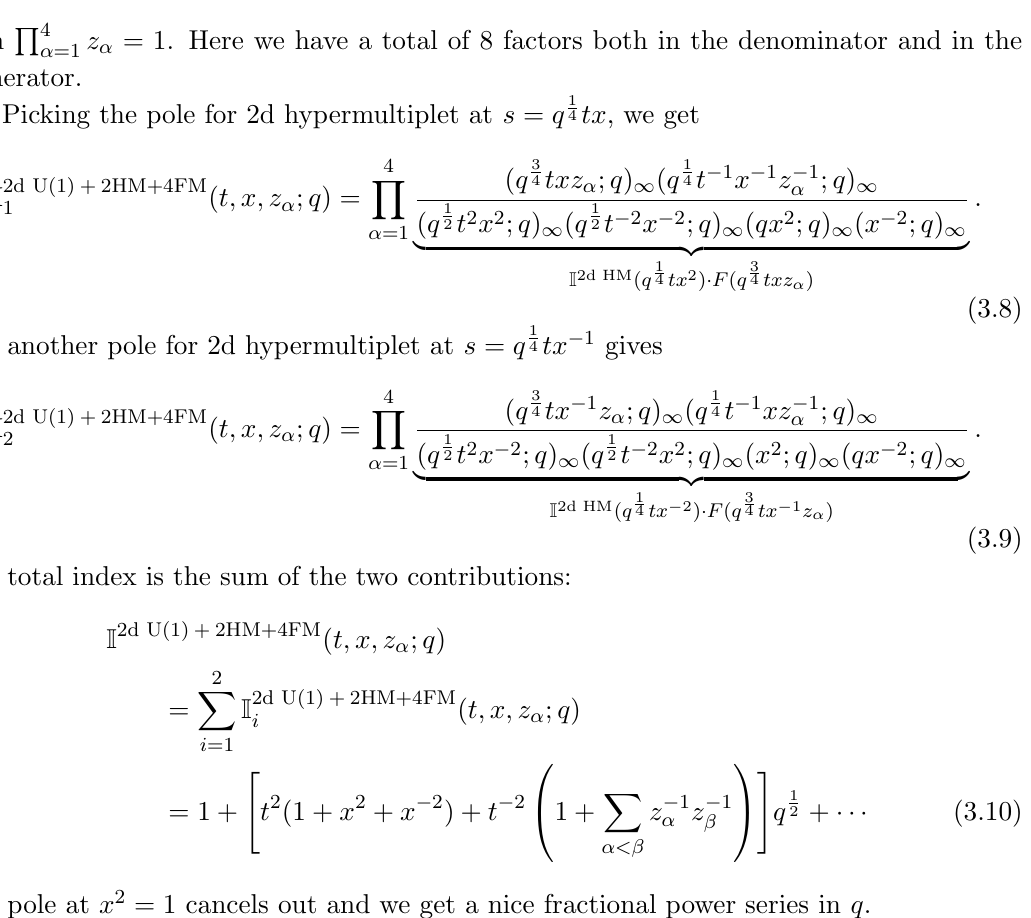
Figure 2 . The brane box configuration of 2d hypermultiplets and four charged Fermi multiplets and the S-dual